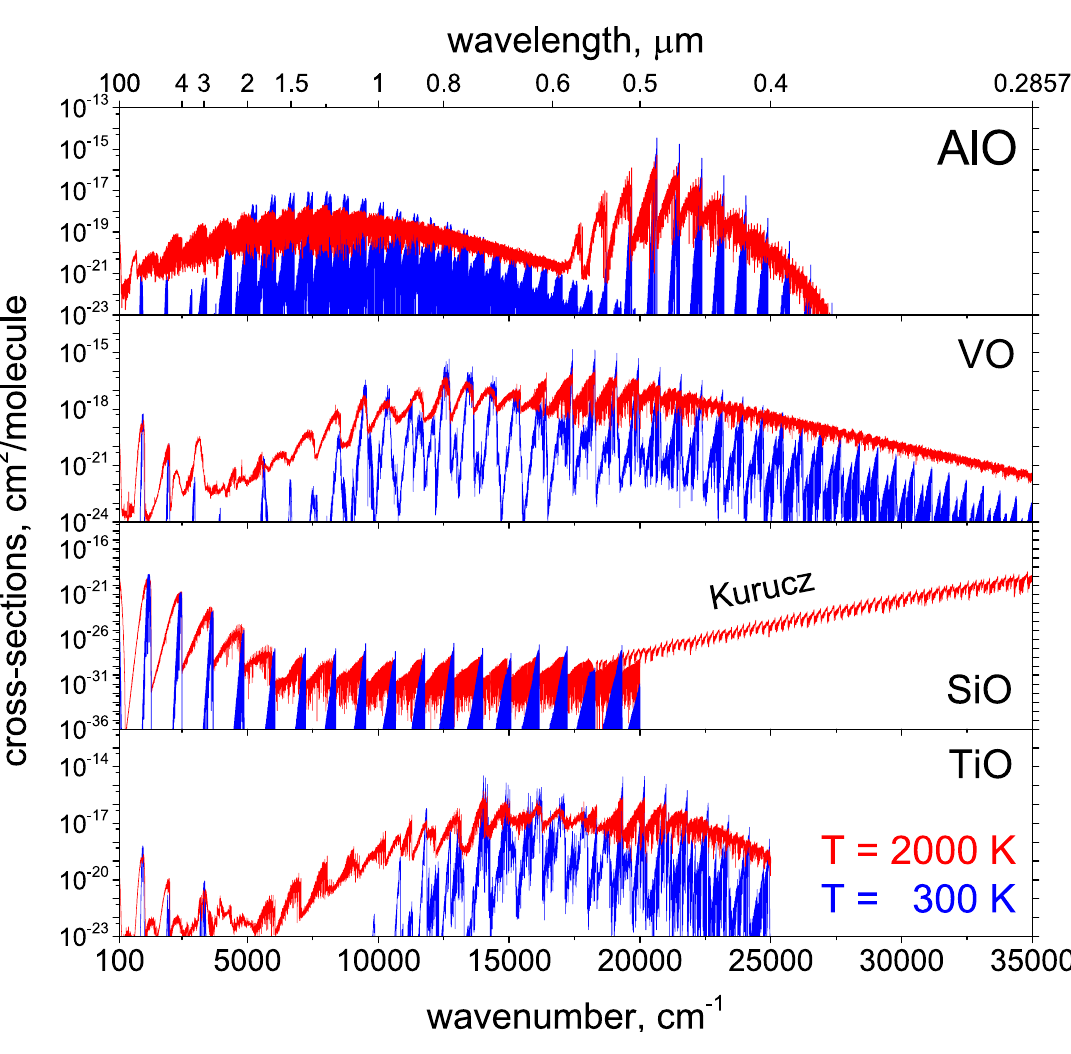
Figure 14. Cross sections for metal oxides generated using ExoMol line lists for silicon monoxide [52], aluminium monoxide [58] and vanadium monoxide [67]. The titanium monoxide cross sections are based on the computed line list due to Schwenke [89]. Also shown are short-wavelength silicon monoxide cross sections generated using line data from the database due to Kurucz